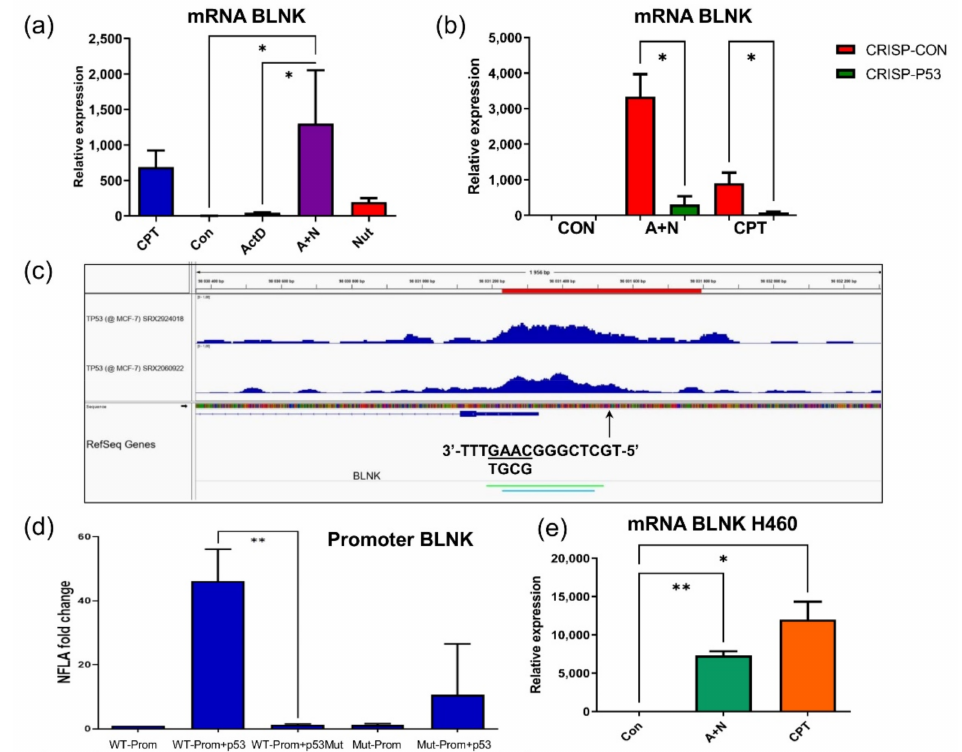
Figure 4. The p53 protein activates expression of BLNK gene from response element in promoter region. ( a ) Changes in the levels of BLNK mRNA, measured by semi-quantitative real-time PCR of samples isolated from mock-treated A549 cells (Con) or from cells incubated for 30 h as indicated. The mRNA level in the mock-treated population was defined as 1. Results represent means and standard deviations from three biological replicates, p values calculated by one-way analysis of variance (ANOVA) with uncorrected Fisher’s LSD (* p < 0.05). ( b ) The expression of BLNK mRNA determined by semi-quantitative RT-PCR in mock-treated control cells (Con) and in the cells exposed to A + N or CPT for 30 h. The A549 cells with knocked-down p53 are marked as “CRISP-p53”, whereas the controls for knock-down are “CRISP-Con”. The results represent means and standard deviations from three biological replicates, p values were calculated by Kruskal-Wallis statistic test with uncorrected Dunn’s test (* p < 0.05). ( c ) Genome browser (IGV) views of p53 binding peak in the promoter of BLNK . Using ChIP-Atlas tool [15] we imported publically available coverage tracks from two ChIP-Seq experiments aimed at finding p53 binding sites in MCF-7 cell line exposed to ionizing radiation and nutlin (sample ID SRX2924018) or in MCF7 cells treated with nutlin alone (sample ID SRX2060922). The red bar above the tracks marks the promoter sequence cloned in the reporter plasmid. We marked the location of the 3Q p53 response element identified by Tebaldi et al. [16] by an arrow. The 3Q sequence is shown from right to left to match the direction of BLNK gene shown by the genome browser. Note that the 3Q element is located near the transcription start site. The position of nucleotide changes generated in mutant promoter are underlined. The nucleotides in the mutation are shown below. ( d ) The fold change of the normalized firefly luciferase activity (NFLA) in U-2 OS cells transfected with the reporter vector coding for firefly luciferase under the transcriptional control of BLNK promoter and either empty vector, expression plasmid coding for wild-type p53 or the expression plasmid coding for mutated p53 (Val143Ala). “Mut” prefix indicates the BLNK promoter version with the mutated p53 response element as indicated on panel c. The means and standard deviations from three biological replicates performed in triplicate are shown, p values calculated by Brown-Forsythe and Dunnett’s T3 multiple comparisons. ( e ) Measurement of relative BLNK mRNA level in NCI-H460 cells exposed to indicated substances or their combinations for 30 h, p values calculated by Brown-Forsythe and Welch’s ANOVA tests (* p < 0.05, ** p <